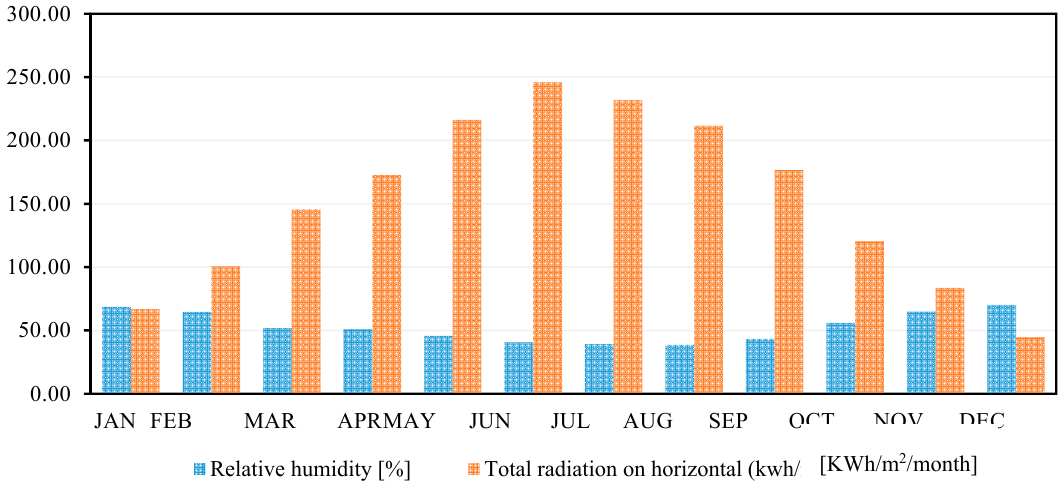
Figure 4. Monthly average RH and total radiation for the years between 2000 and 2010.